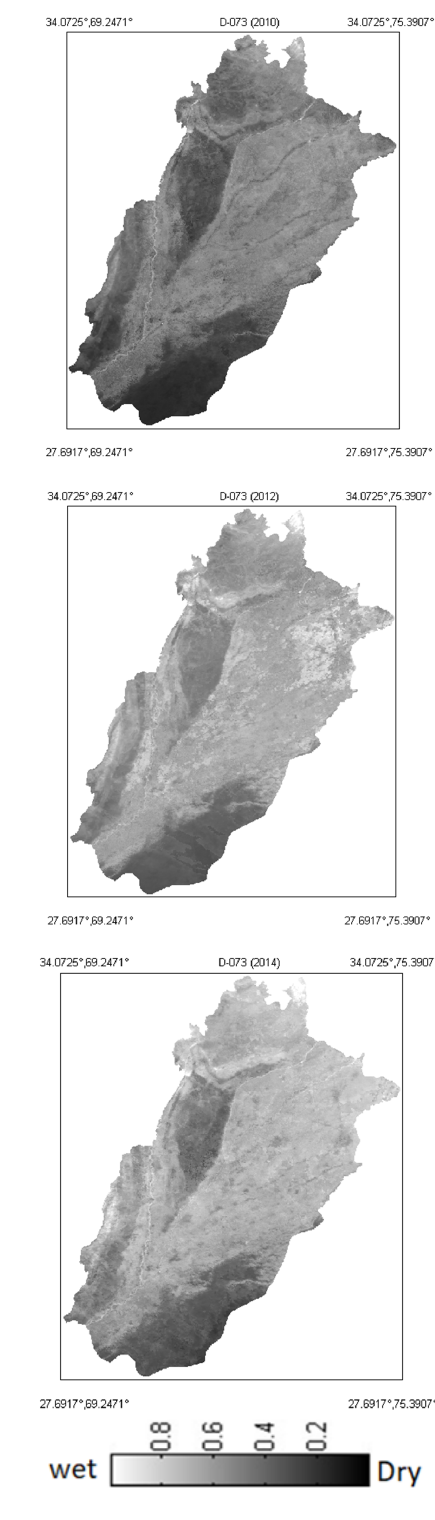
Figure 4. Determination of VTCI drought monitoring results on a scale of (dry to wet) or (0 to 1) in the first 16 days of March (D-073), using the single-year maximum-value composite of LST and NDVI products to determine the warm edges and cold edges in 2003–2014, using the single year-maximum- value compositing approach to determine the warm edge, and the maximum–minimum-value compositing approach to determine the cold edges. This yields the MODIS VTCI drought imageries. The selected images are highly correlated during the winter wheat crop growing season at D-073 during